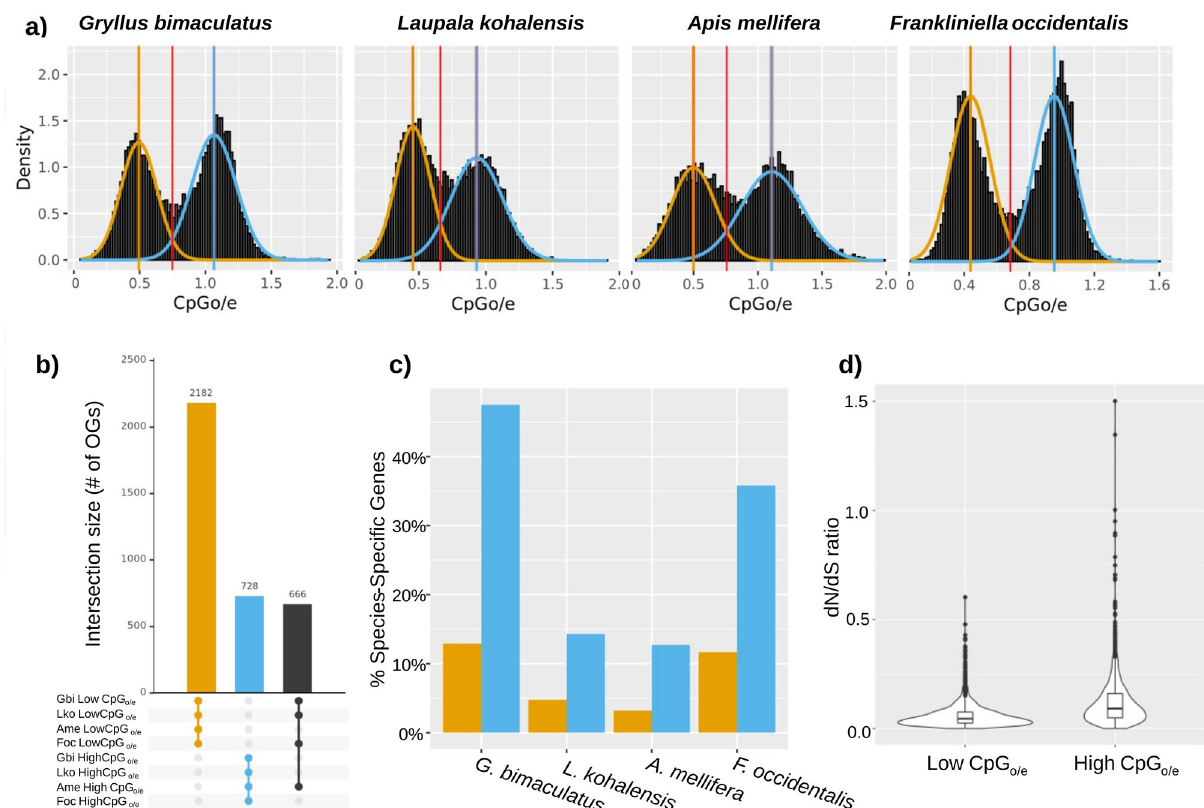
Fig. 2 CpG o/e bimodal distribution across distant insects. a The distribution of CpG o/e values within the CDS regions displays a bimodal distribution in the two cricket species studied here, as well as in the honeybee A. mellifera and the thrips F. occidentalis . We modeled each peak with a normal distribution and de fi ned their intersection (red line) as a threshold to separate genes into low- and high- CpG o/e value categories, represented in yellow and blue respectively. b UpSet plot showing the top three intersections (linked dots) in terms of the number of orthogroups (OGs) commonly present in the same category (low- and high- CpG o/e ) across the four insect species. The largest intersection corresponds to 2182 OGs whose genes have low CpG o/e in the four insect species, followed by the 728 OGs whose genes have high CpG o/e levels in all four species, and 666 OGs whose genes have low CpG o/e in the three hemimetabolous species and high CpG o/e in the holometabolous honeybee. Extended plot with 50 intersections is shown in Supplementary Fig. 4. c Percentage of species-speci fi c genes within low CpG o/e (yellow) and high CpG o/e .(blue) categories in each insect, indicating that more such genes tend to have high CpG o/e values. d One-to-one orthologous genes with low CpG o/e values in both crickets have signi fi cantly lower dN/dS values than genes with high CpG o/e